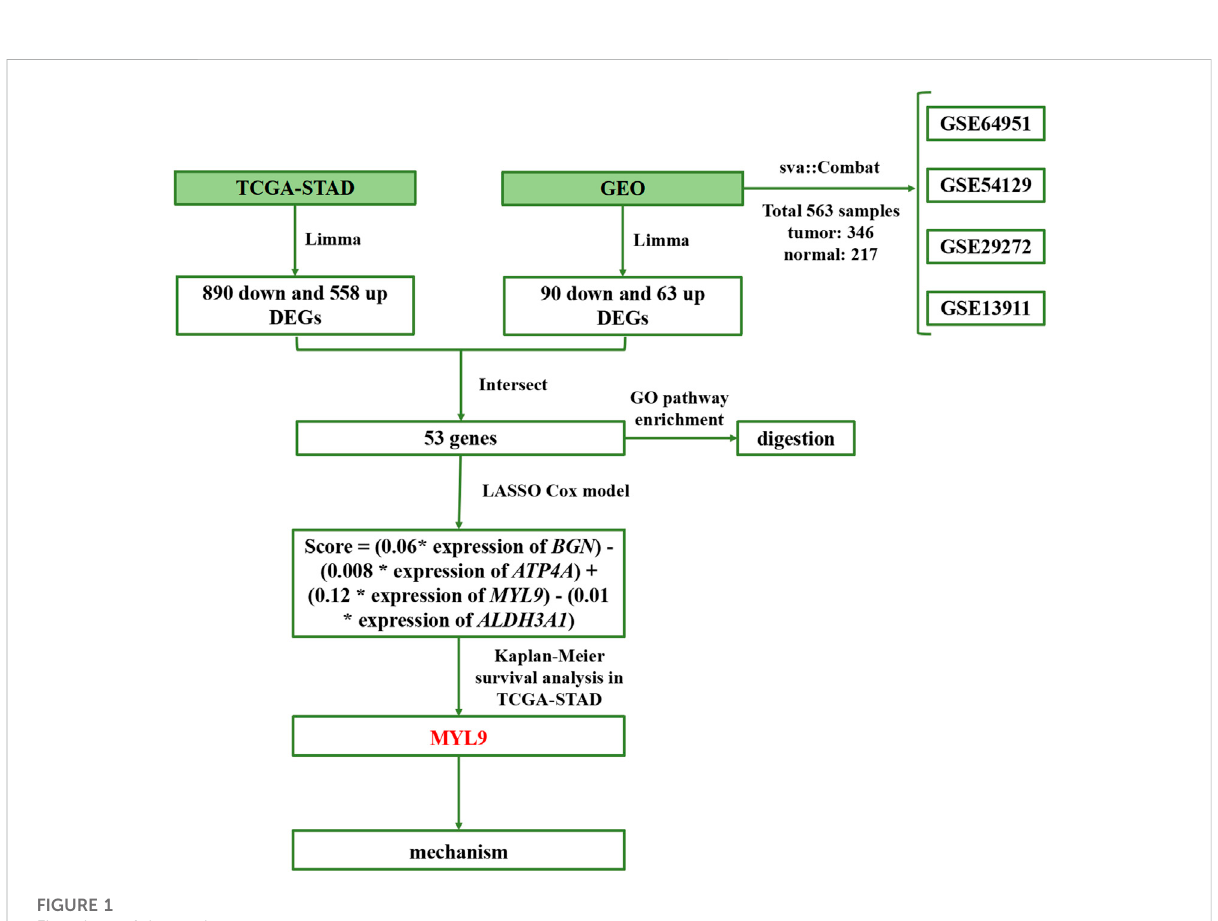
FIGURE 1 Flowchart of the